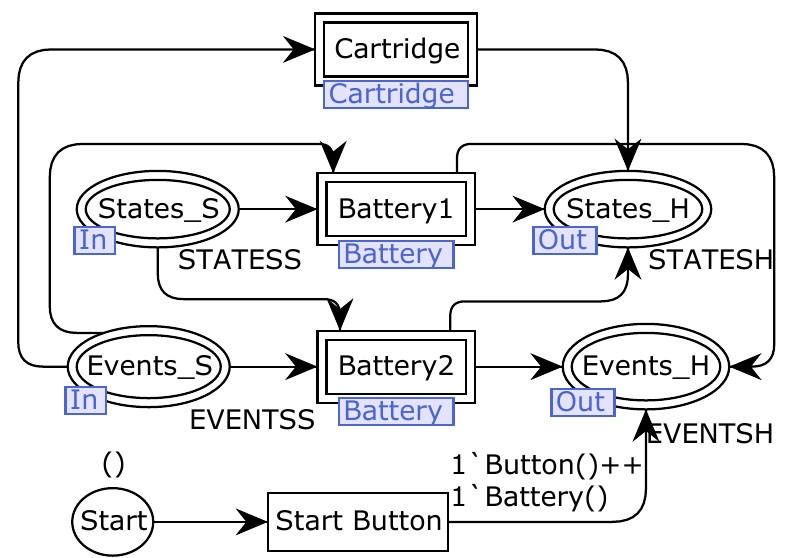
Figure 6. The hardware module of insulin infusion pump systems with two